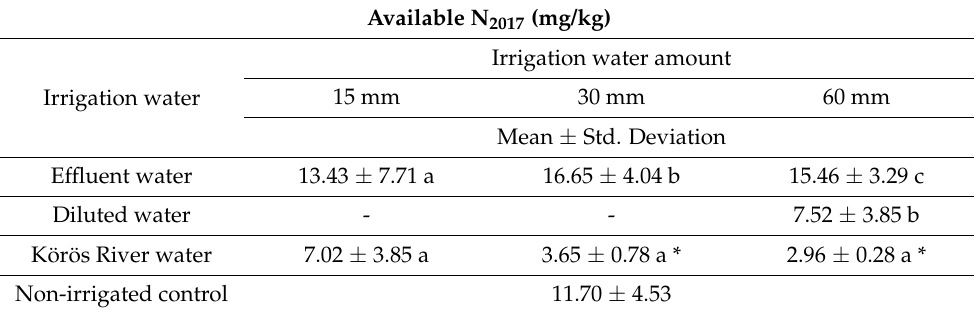
Table 5. Available nitrogen (KCl-NO 2 − +NO 3 − -N) content of soil in